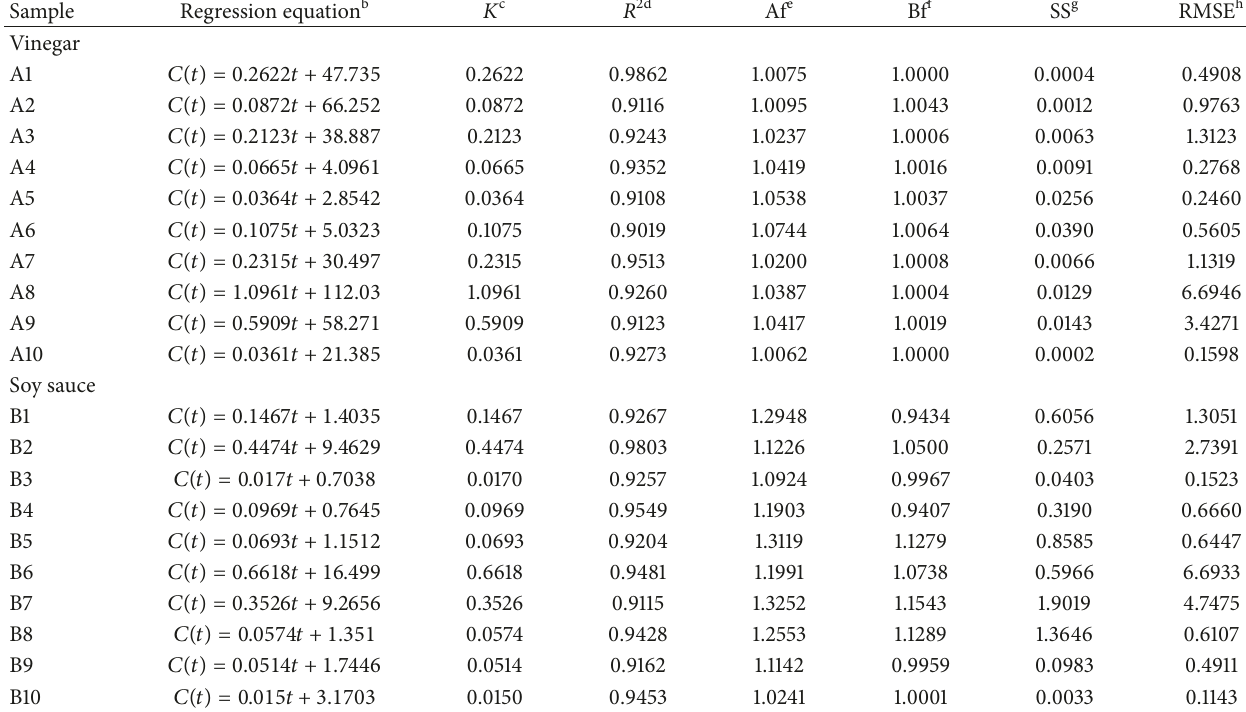
Table 2: Summary of kinetic analysis of HMF formation in different heating treatment vinegar and soy sauce samples.